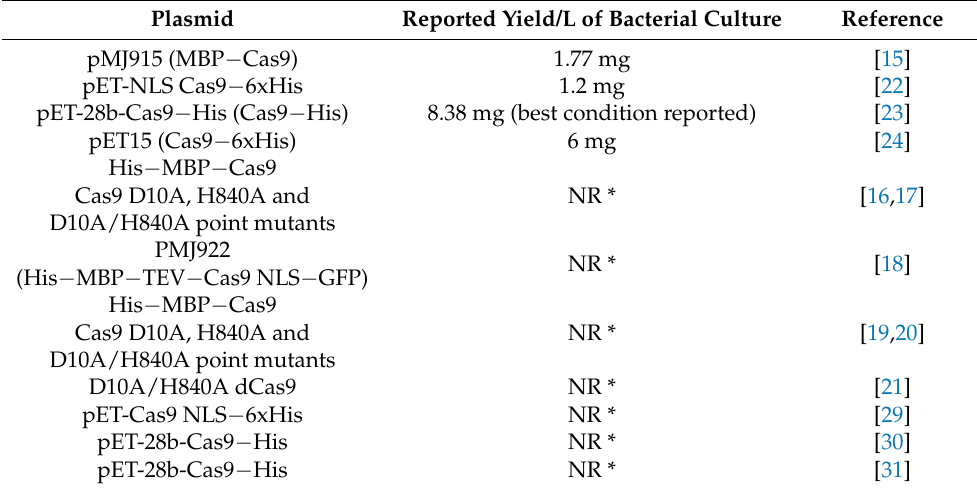
Table 1. Cas9 expression and purification protocols. Plasmid Reported Yield/L of Bacterial Culture Reference pMJ915 (MBP −